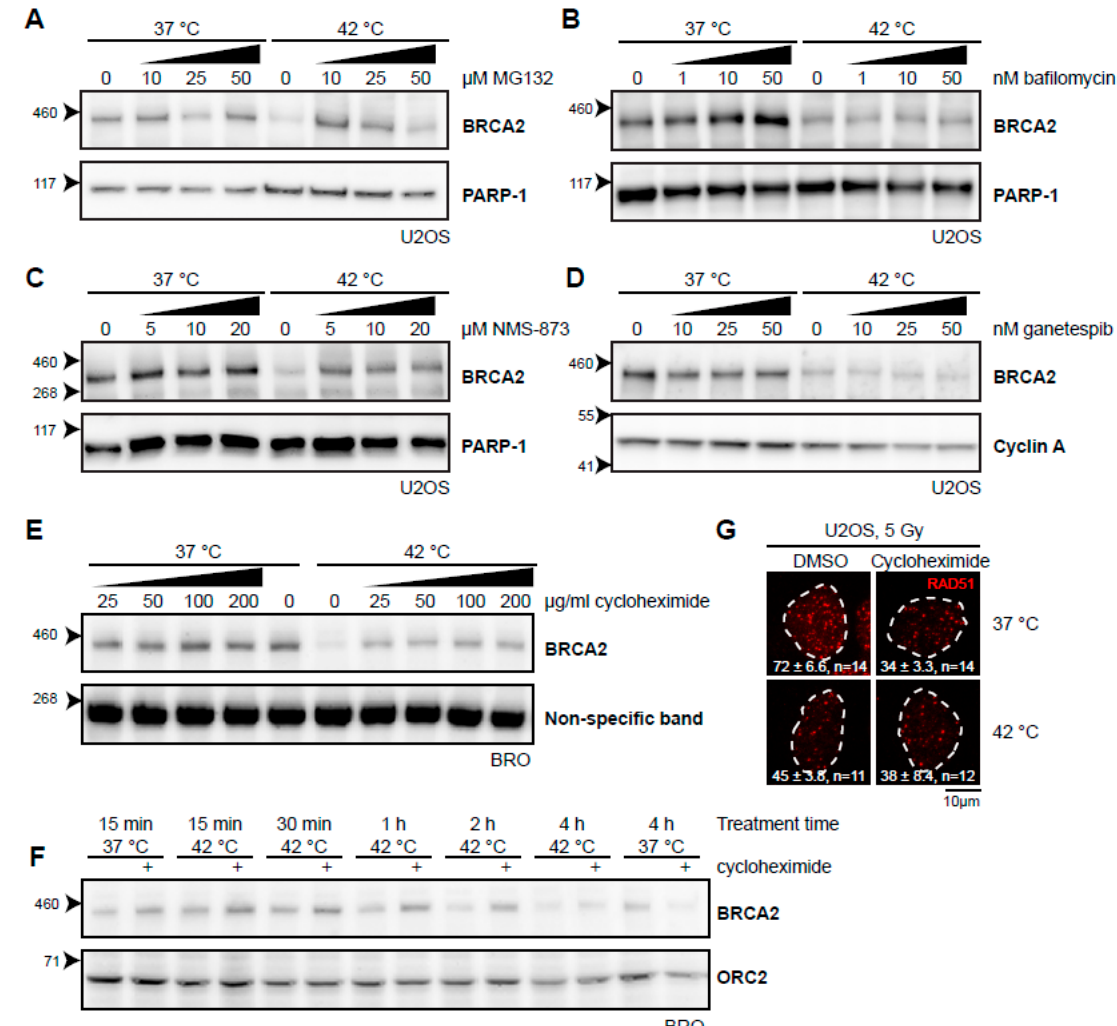
Figure 2. Various inhibitors alter the heat-mediated BRCA2 degradation. ( A – E ) Immunoblots of cells treated with or without 60 min of hyperthermia in the presence of indicated doses of different inhibitors. All inhibitors were added 30–60 minutes prior to hyperthermia treatment. ( A ) Human Bone Osteosarcoma U2OS cells treated with the proteasome inhibitor MG132. ( B ) HeLa cells treated with the autophagy inhibitor bafilomycin A1. ( C ) U2OS cells treated with an inhibitor of the valosin-containing protein (VCP) segregase. ( D ) U2OS cells treated with the HSP90 inhibitor, ganetespib. ( E ) Lymphoma-derived BRO cells treated with the translation inhibitor, cycloheximide. ( F ) BRO cells treated with cycloheximide (50 µg/ml) and hyperthermia for the indicated periods of time. ( G ) U2OS cells were treated with or without hyperthermia in the presence of dimethylsulfoxide (DMSO) and cycloheximide, irradiated with 5 Gy, and fixed 90 min after irradiation. Cells were stained for 5-ethynyl-2’-deoxyuridine (EdU) and the protein product of the Radiation 51 RAD51 gene. The panel shows the RAD51-staining for representative cells for each condition. The dotted line indicates the perimeter of an EdU-positive nucleus. Numbers in the panel indicate the mean number of foci ± standard error of the mean and the number of cells analyzed.